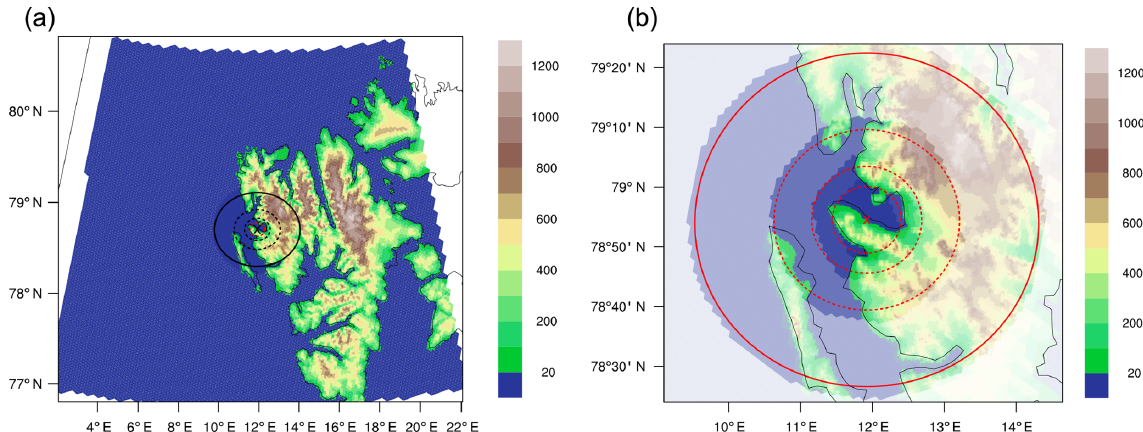
Figure 1. The topography (m), domain size and resolution around Ny-Ålesund for the 2km ICON-NWP simulation (a) and the nested ICON- LEM simulations (b) . The circles indicate the model domains for the 600, 300, 150 and 75 m horizontal resolution model runs, respectively (from outer to inner circle) with corresponding domain sizes of approximately 110, 60, 35 and